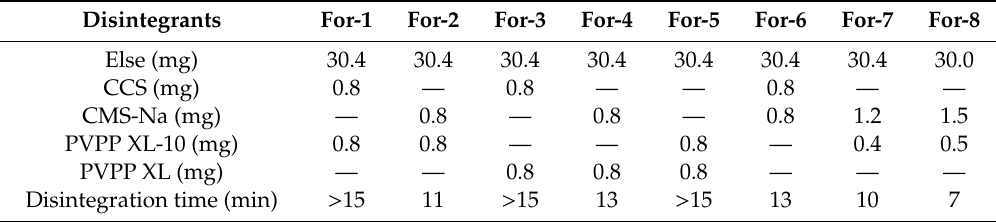
Table 4. The screening results of the disintegrants.